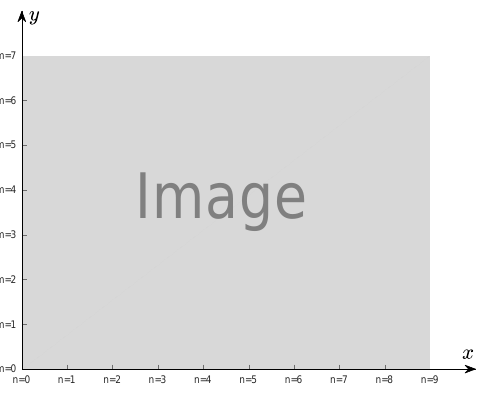
Figure 1. Illustration of the Cartesian coordinate system and integer coordinates ( n , m ).